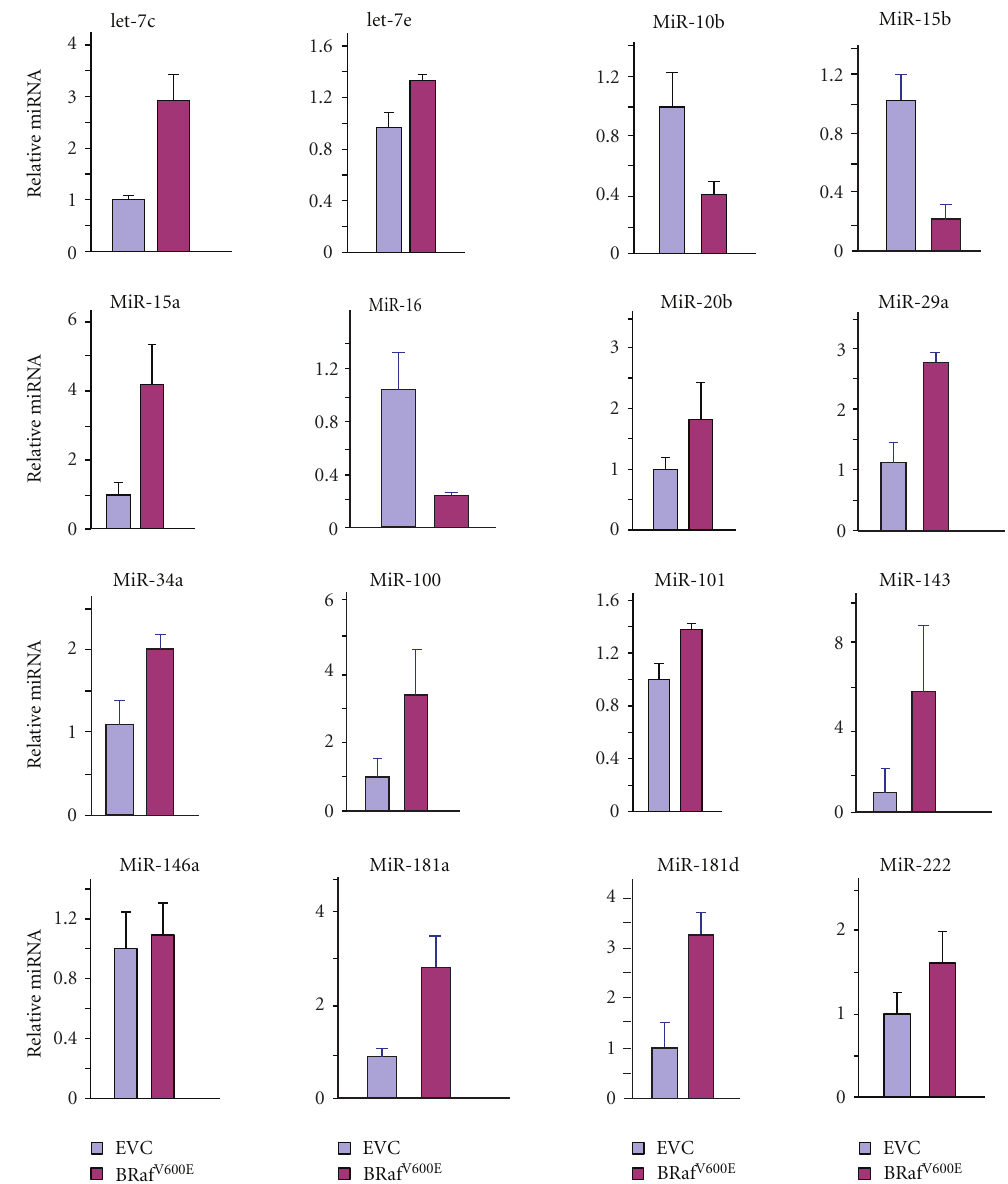
Figure 2: Melanocytes were infected with EVC or with vector expressing BRaf V600E . Cells were harvested 4 days after infection and the expression levels of the indicated miRNAs were quantified by qRT-PCR with specific primers (Biosciences) and normalized to the level of U6 RNA. The values represent the means and standard deviation from three independent